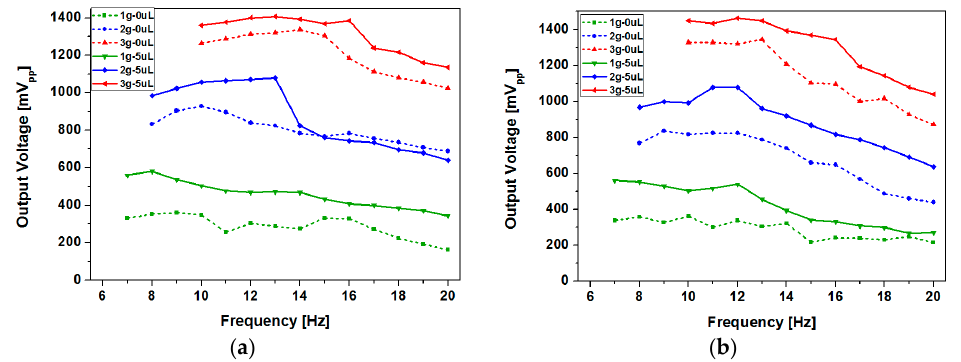
Figure 11. Peak-to-peak open circuit voltage at various input frequencies and accelerations when channels of different surface roughness are used: ( a ) type 1; ( b ) type 2.